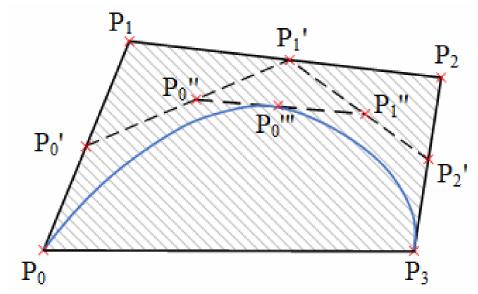
Figure 8. Schematic diagram of the Bezier curve of order